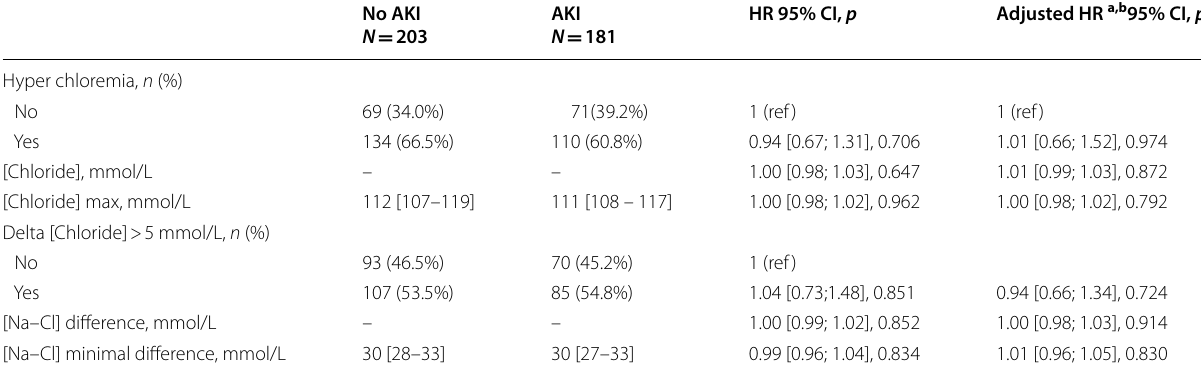
a Adjusted for SAPS, surgical admission, weigh, chronic kidney disease, diabetes, SOFA and ARDS at H0 and for the following time-dependent variables: serum creatinine, vasopressor dose, volume of fluid resuscitation b Adjusted models were developed in the 340 patients free of RRT at inclusion and without missing data